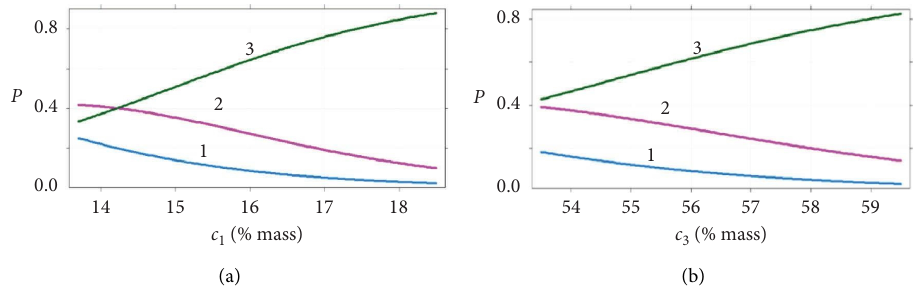
Figure 4: Probabilities P of responses of diferent color categories in dependence on content of (a) protein c fractions, %. Each plot is calculated at contents of other main components equal to their observed mean values in Table 4. Te line numbers are as in Figure